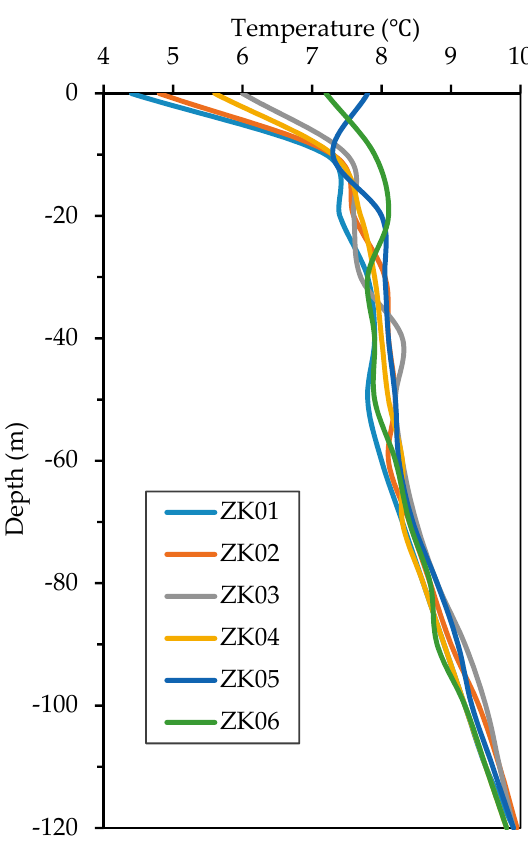
Figure 4. Temperature profiles along different boreholes.